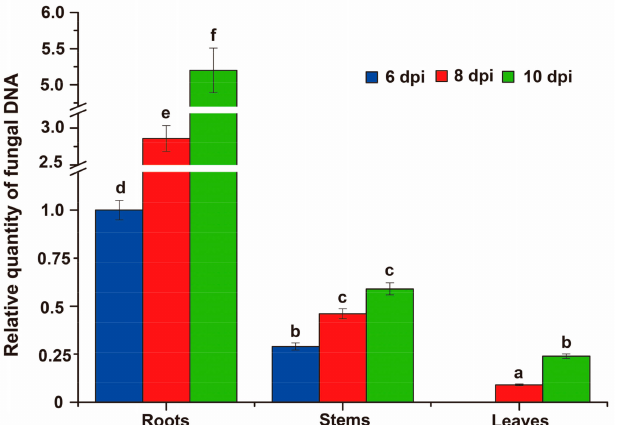
Figure 8. Quantitative real time polymerase chain reaction (qRT-PCR) quantification of fungal DNA extracted from root, stem, or leaves of seedlings of N. benthamiana at six, eight, and ten days after inoculation with Vd-m . Fungal biomass was determined using ITS1 and ITS2 of V. dahliae ribosomal DNA relative to the referenced Nbactin gene. Error bars represent standard errors calculated for three independent replicates. Different letters indicate significant differences among the tissues, as determined with a least significant difference (LSD) test ( p <